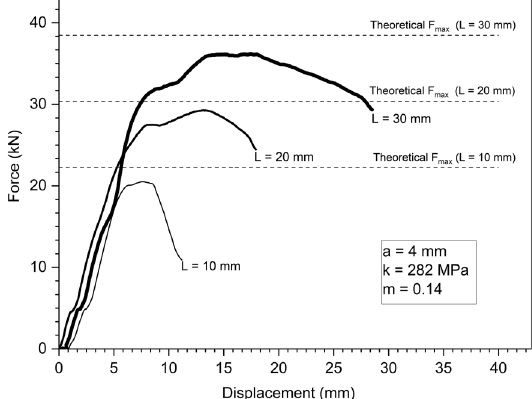
Figure 5. Experimental ECAP load–displacement curves at room temperature for different billet lengths: 10, 20 and 30 mm.